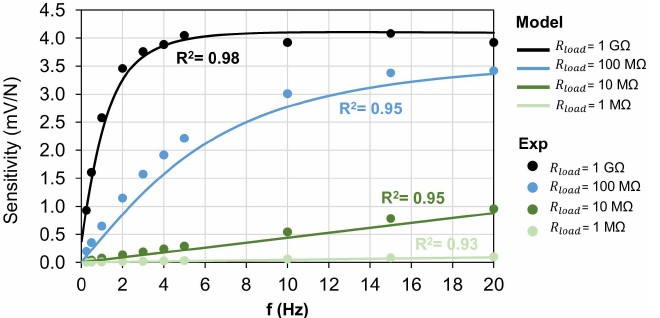
Figure 10. Sensitivity of the piezoelectric sensor vs. the frequency of the compressive force for different values of R load